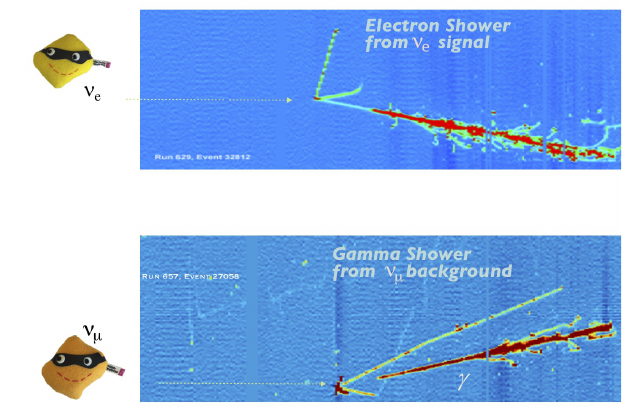
Figure 2. Electron neutrino appearance signal (top) and background (bottom) as seen in the ArgoNeut experiment[2]. In the true appearance signal, an electron is seen emerging from the primary vertex and then showering. In the background interaction, a muon neutrino enters and produces a final state muon and photons, which propagate some distance before showering.